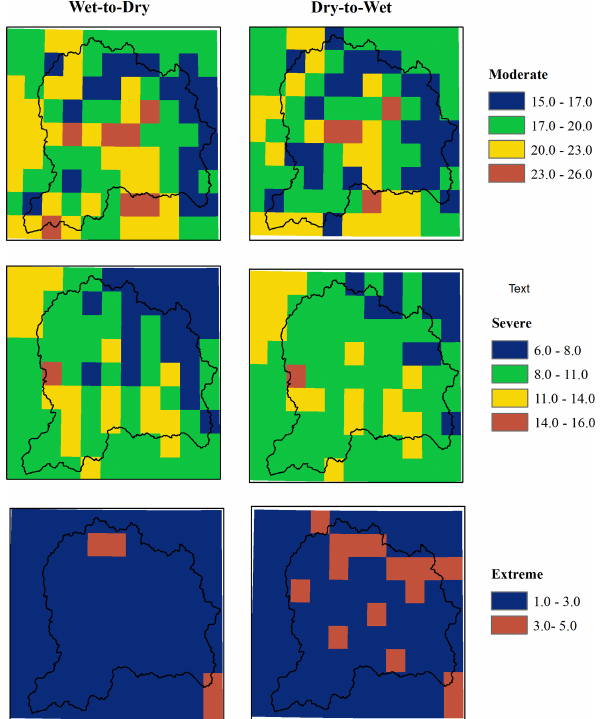
Figure 9. Average transition time ( T t ) intervals in months for wet- to-dry (left) and dry-to-wet (right) events for three levels of severity (moderate, severe, extreme) for the period 1981–2014.